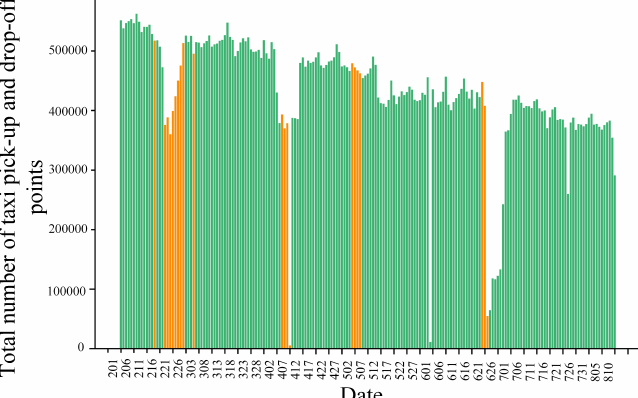
Figure 2. Total number of taxi pick-up and drop-off data per day (Zhang,